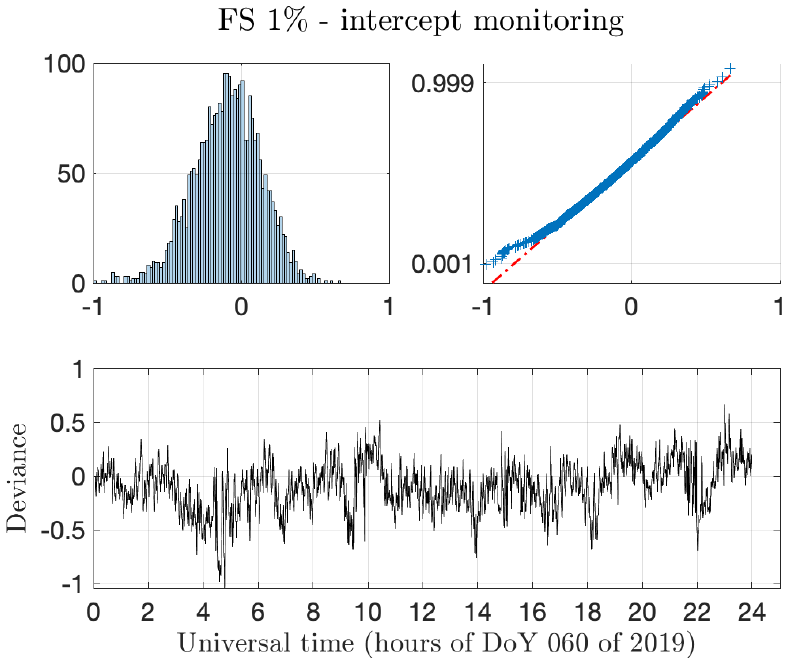
Figure 11. Monitoring the intercept estimates obtained with the FS on the basis of a moving time window of 10 epochs. Small deviances of the intercept estimates around zero indicate that the estimated pre-fit position remains stable. The time monitoring of the deviances (bottom panel) is complemented by views on the intercept fluctuations distribution (top left histogram) and normality departure (top right normal probability plot). The x axes of the upper panels refer again to the deviance, while the y axes refer, respectively, as it is customary, to the bin frequencies and the cumulative normal distribution function evaluated at the empirical deviance